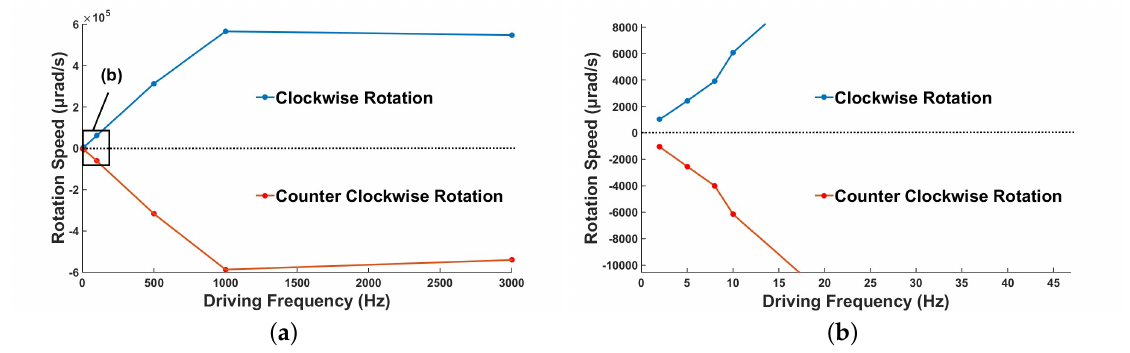
Figure 17. Rotation speed under various driving frequencies: ( a ) rotation speed for a driving frequency of 2 Hz to 3 KHz; and ( b ) magnified data for low